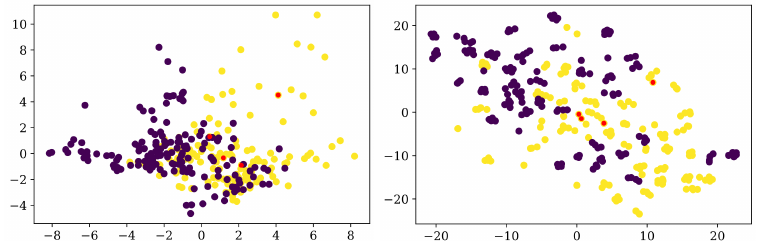
Figure 6. A 2D representation of the MedD dataset with the entries for one particular participant (a PD patient) marked in red; again, we represent PD patients in yellow and participants in the HC group in